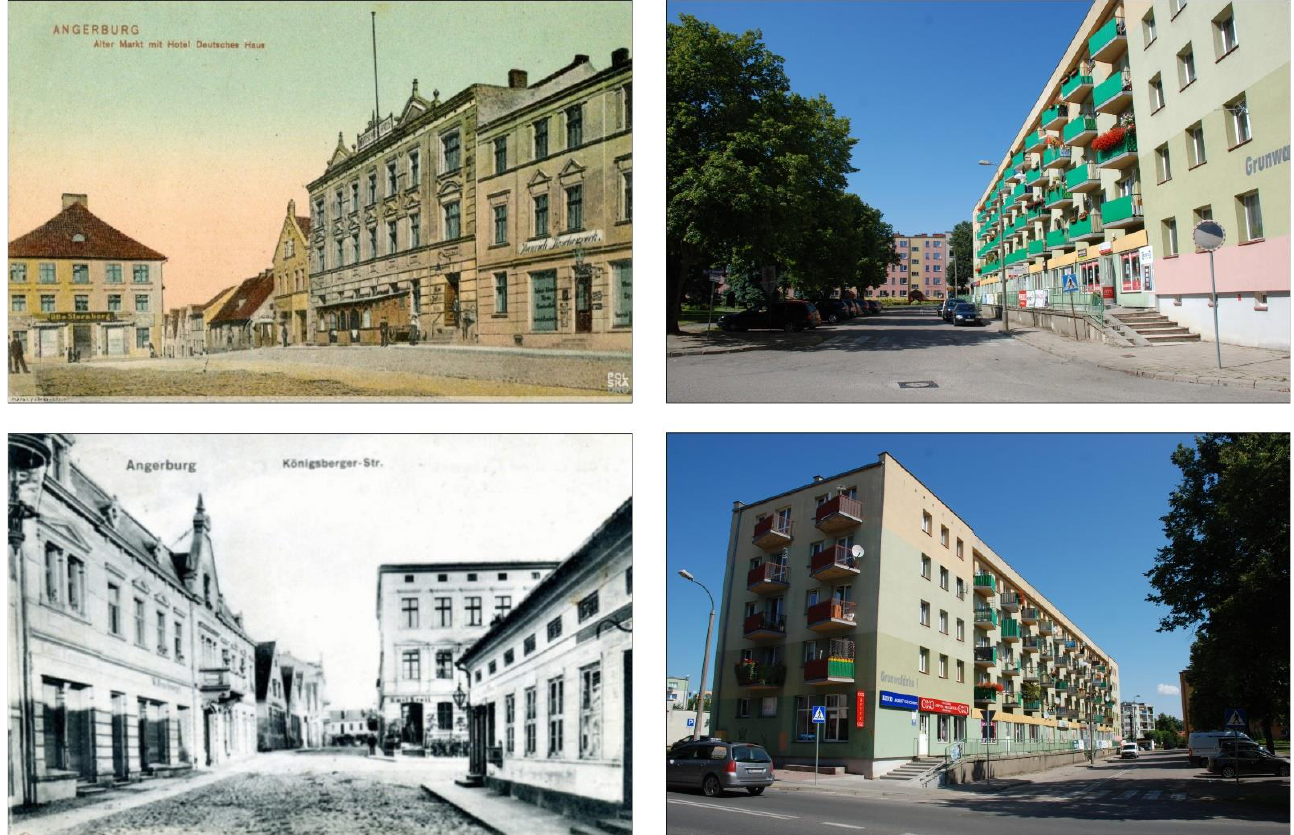
Figure 6. Comparison of archival and contemporary views of the former Altmarkt and Holzmarkt and the present Grunwald Square, 1910 – 1915. Source: [105,106].